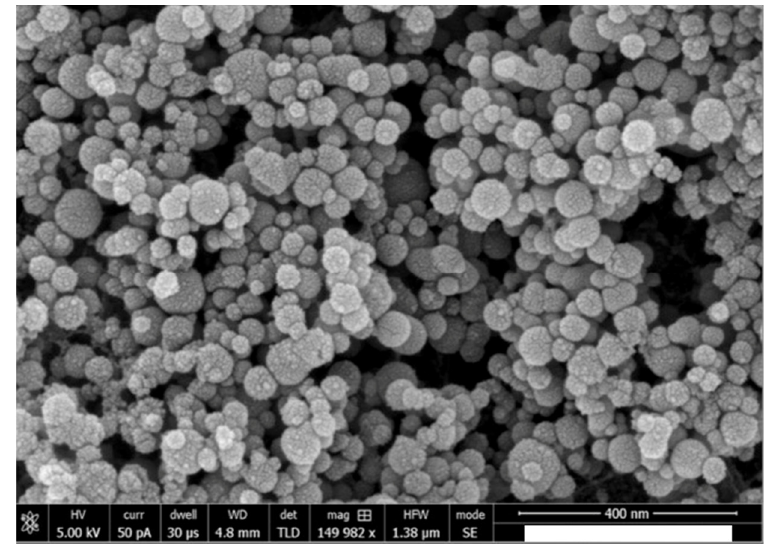
Figure 1. The morphological shape and size of the nanoparticles is depicted. It is noted that the size of the nano-hydroxyapatite (n-HA) particles are in nanoscale with a mean average size of <100 nm in diameter.